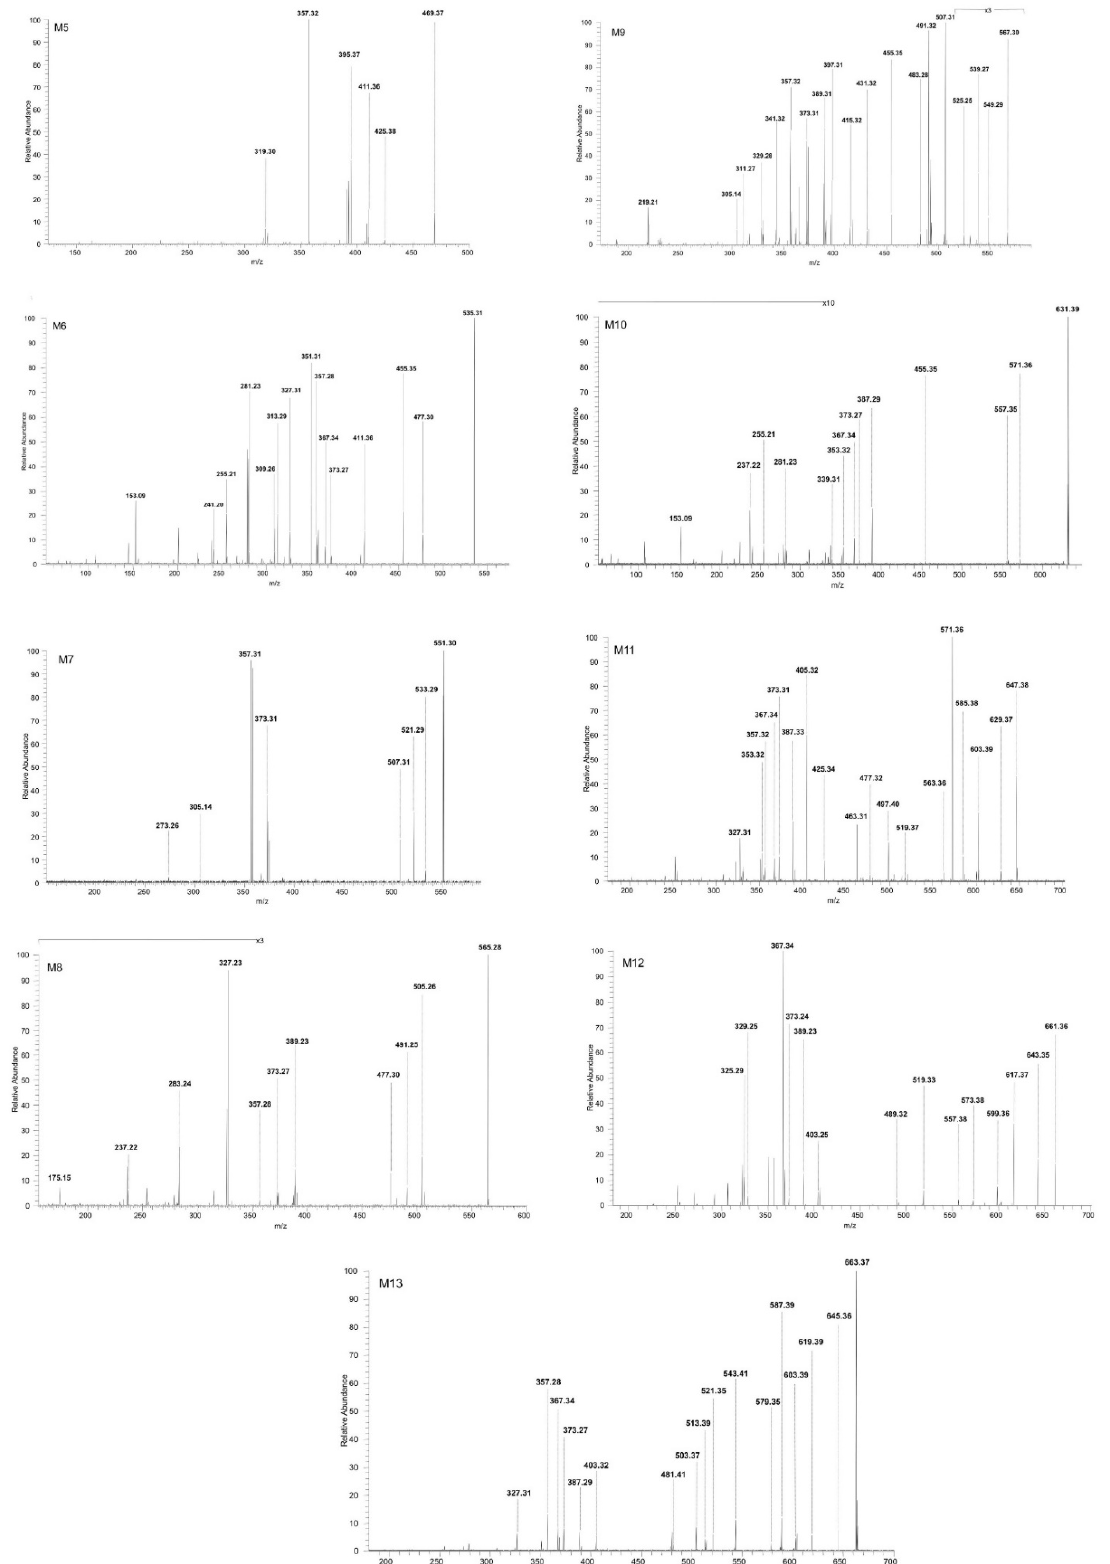
Figure 6. ESI CID MS/MS spectra in the negative ion mode of phase II metabolites detected as [M-H] − ions: M5 ( m / z 469.37), M6 ( m / z 535.31), M7 ( m / z 551.30), M8 ( m / z 565.28), M9 ( m / z 567.30), M10 ( m / z 631.39), M11 ( m / z 647.38), M12 ( m / z 661.36) and M13 ( m / z 663.37); spray voltage 0.70 kV, capillary temperature 275 ◦ C and collision energies within 0–35